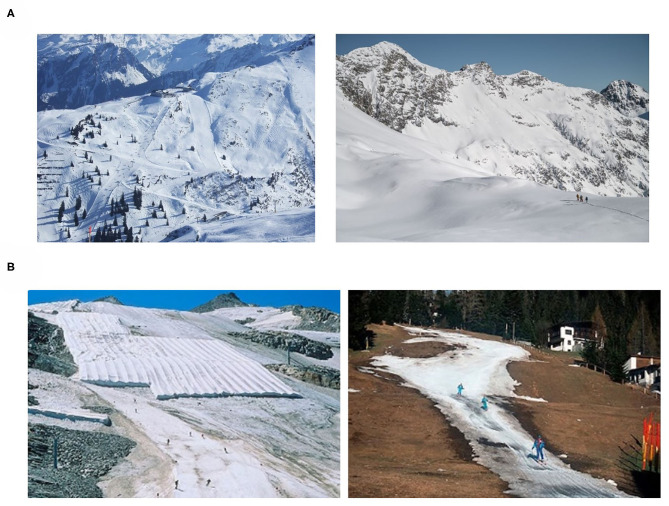
Climate change unaffected scenario (A, upper row) and climate change affected scenario (B, lower row). Pictures B by courtesy of “Gesellschaft für ökologische Forschung.”